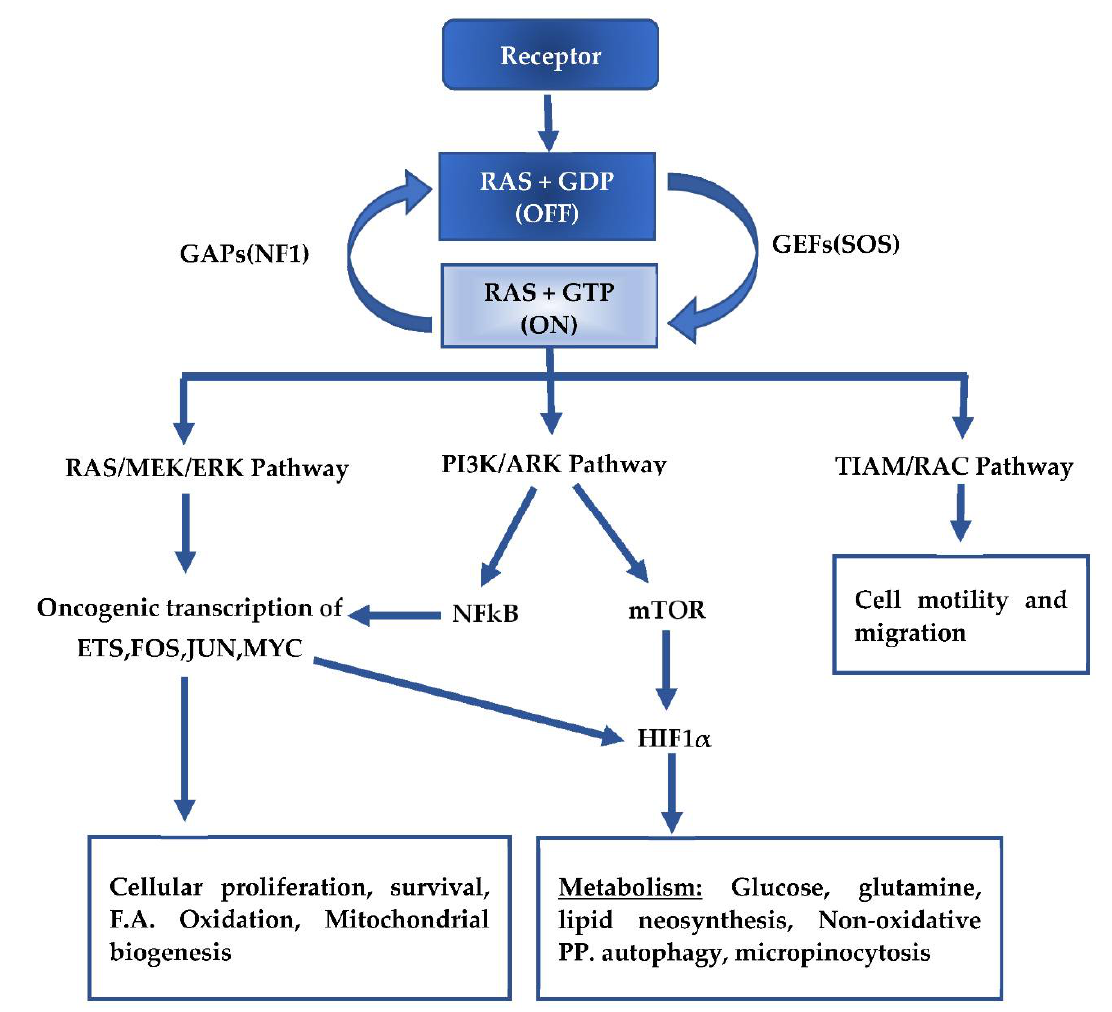
Figure 1. Activation of KRAS and the downstream signaling pathways. “on”—activated KRAS after exchange of GDP for GTP, “off”—inactive KRAS after hydrolysis of GTP to GDP, F.A.—Fatty Acid, PP.—Pentose pathway.